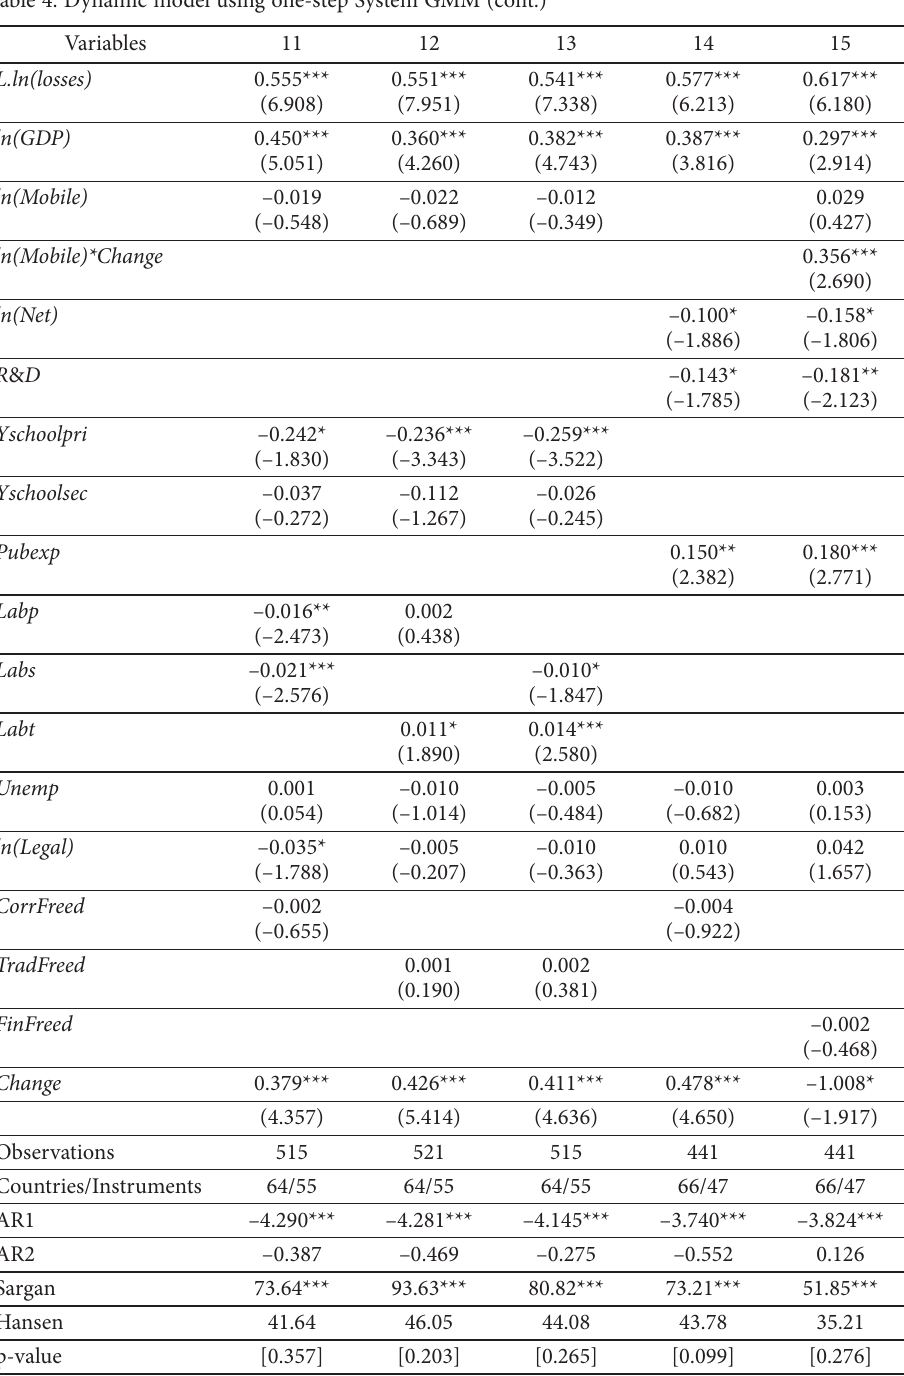
Table 4. Dynamic model using one-step System GMM